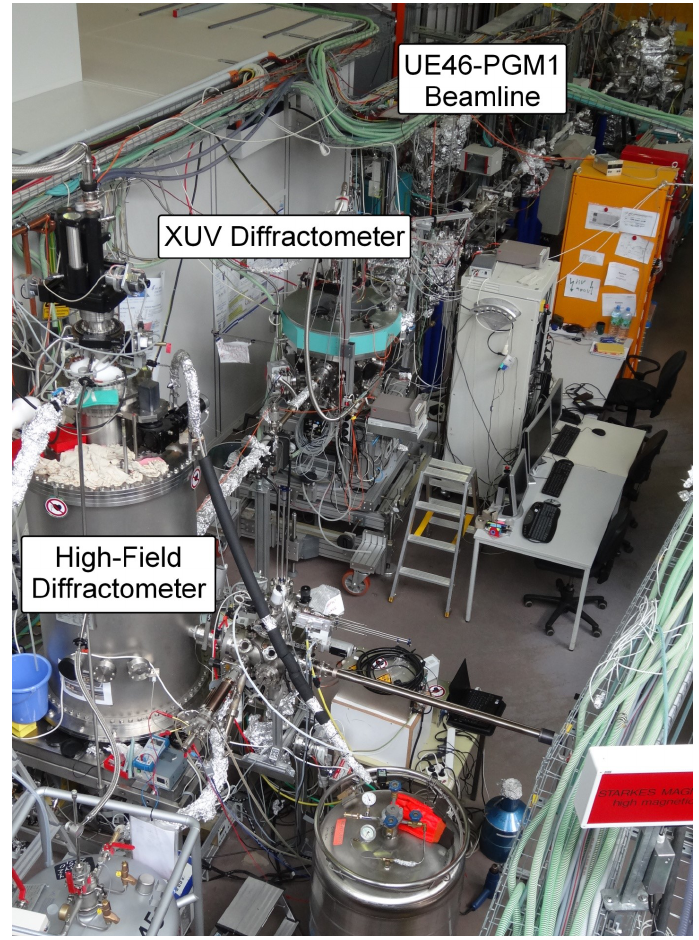
Figure 2: Overview of beamline UE46 PGM-1 with the two